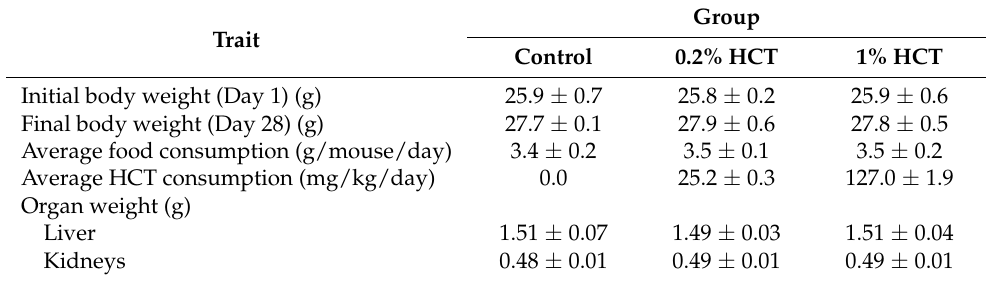
Table 4. Body weight, organ weight, and average HCT consumption in mice treated with